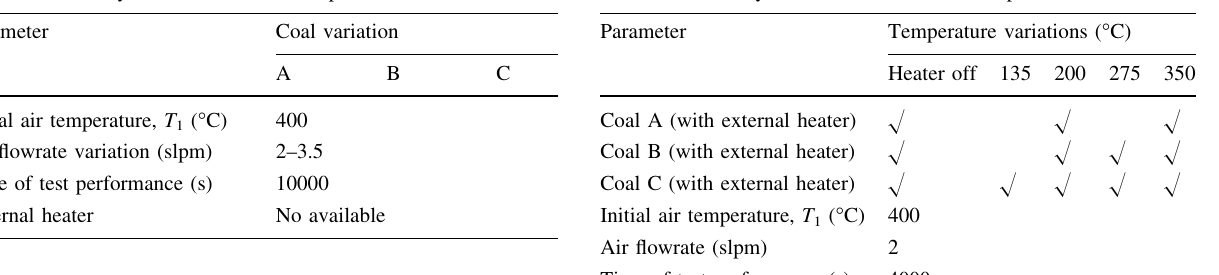
Table 4 Boundary conditions of test with temperature